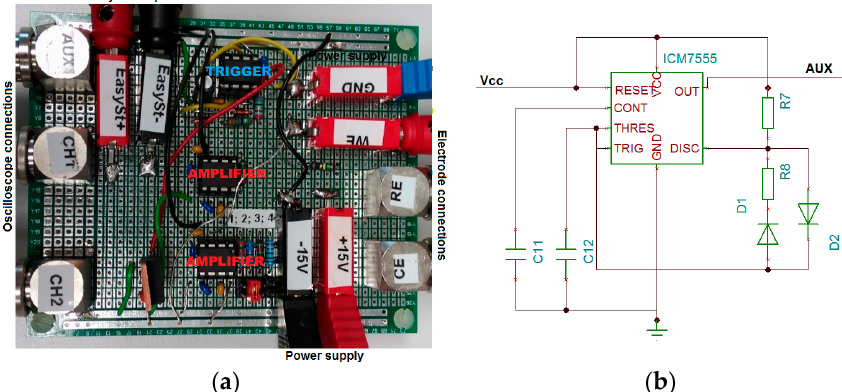
Figure 3. ( a ) Custom circuit board for VT measurements. ( b ) Configuration of timer ICM7555 IPA (Intersil, Milpitas, CA, USA).